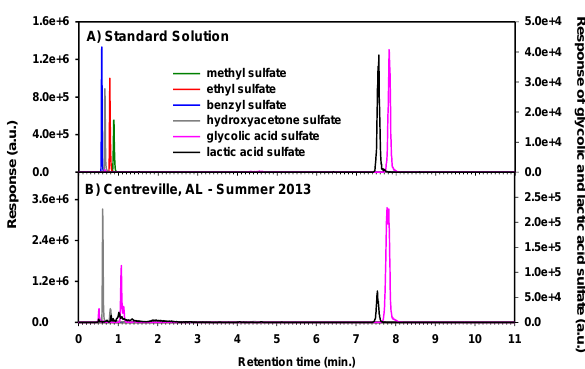
Figure 2. MRM chromatograms of (a) a mixed standard containing six organosulfates at 100µgL − 1 and (b) an ambient aerosol sample collected during the daytime on 10 July 2013 in Centreville, AL. Responses of glycolic acid sulfate and lactic acid sulfate are shown on the right